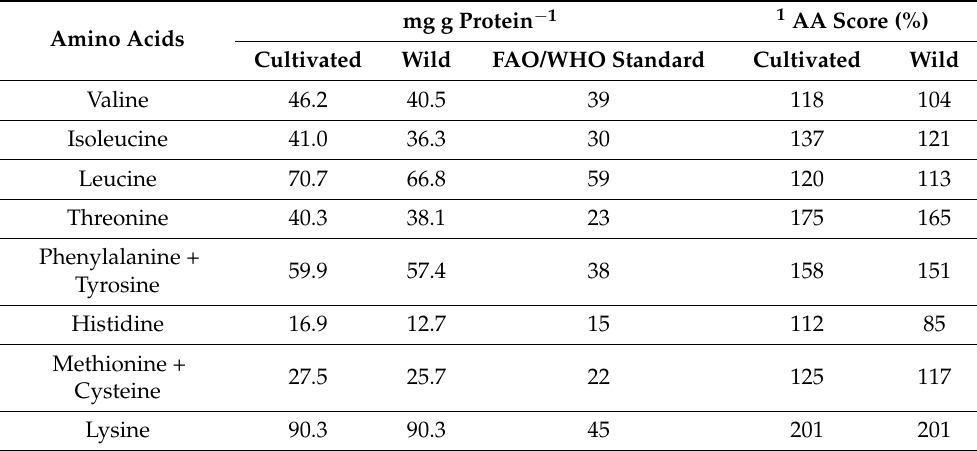
Table 6. Essential amino acid content (mg g protein − 1 ) of wild and cultivated thick-lipped grey mullets compared to the FAO/WHO reference standard (mg g protein − 1 ) and AA scores (%). mg g Protein − 1 1 AA Score (%) Amino Acids Cultivated Wild FAO/WHO Standard Cultivated Wild Valine 46.2 40.5 118 104 Isoleucine 41.0 36.3